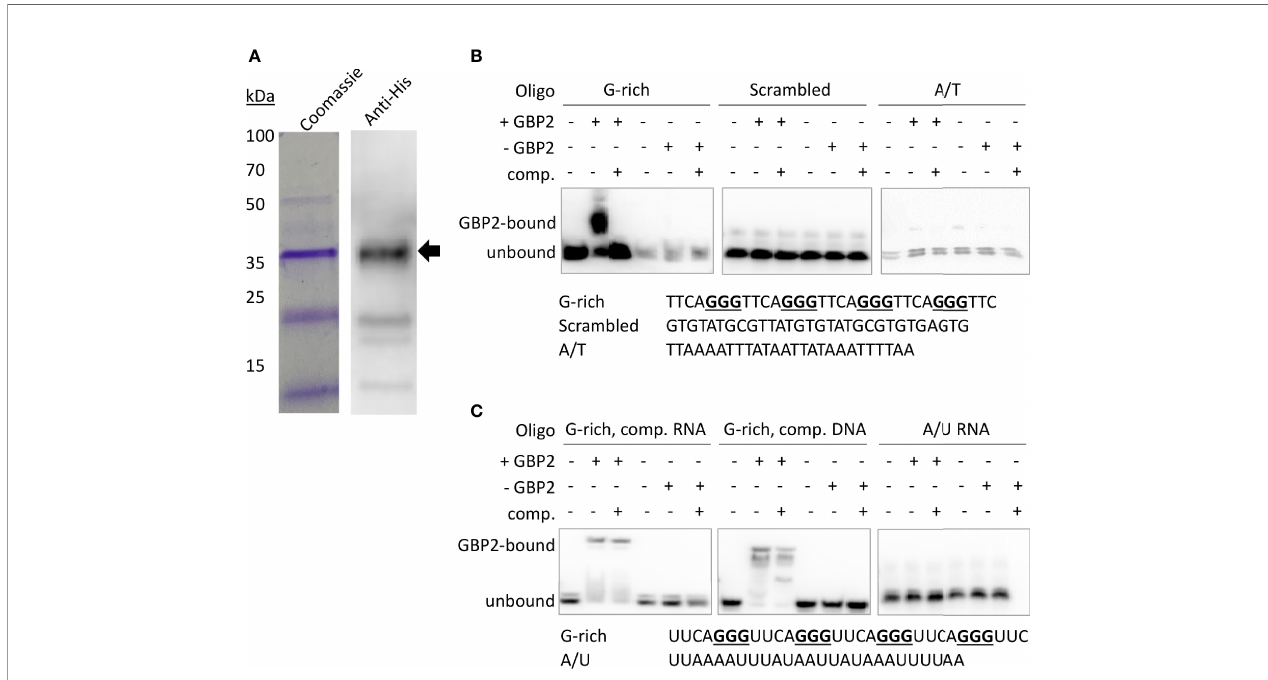
FIGURE 3 | Pf GBP2 binds to telomeric DNA and RNA sequences. (A) Recombinant 6x His-tagged Pf GBP2 (full-length protein marked with arrow), expressed in E . coli and puri fi ed via nickel resin. Coomassie-blue-stained gel and western blot against the 6x His-tag. Images are representative of several independent preparations. (B) EMSA assays with the indicated oligonucleotides and bacterial extract containing Pf GBP2 ( ‘ +GBP2 ’ ), or equivalent extract containing no recombinant protein ( ‘ -GBP2 ’ ) in the control condition. ‘ Comp ’ , unlabeled competitor DNA of the same sequence. Images are representative of several independent experiments. (In all experiments, equal quantities of the A/T control oligo appeared less brightly: this was due to relatively inef fi cient biotinylation of the A/T oligo compared to the G-rich oligos.) (C) EMSA assay as in (B) , using RNA instead of DNA. Competition was attempted with an excess of either unlabeled RNA or unlabeled